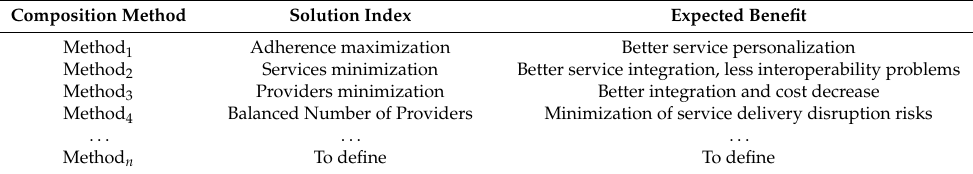
Table 12. Some composition